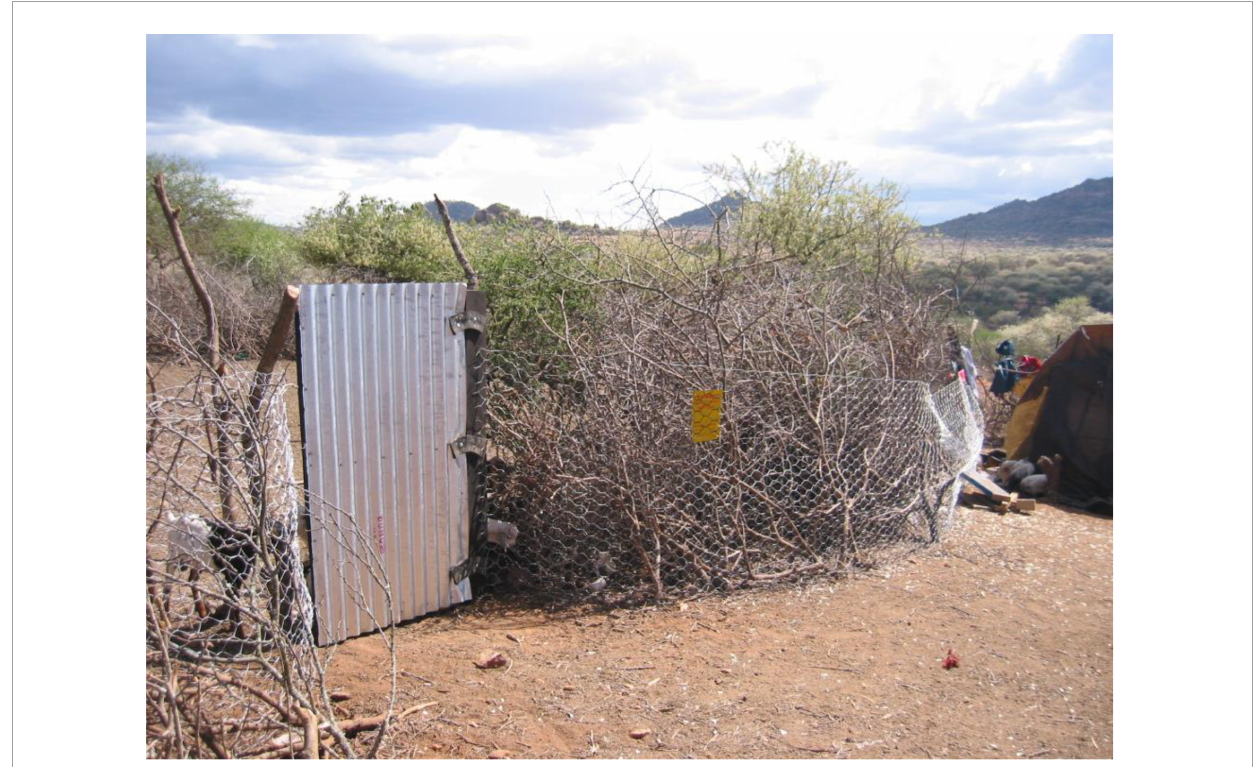
FIGURE9 “Hyena-proof” modification to a light thorn bush boma on a Laikipia pastoralist group ranch. The bush is surrounded by livestock netting laid on the branches and pegged to the ground, and the bush gate replaced with a sheet of corrugated iron or flattened 200 liter